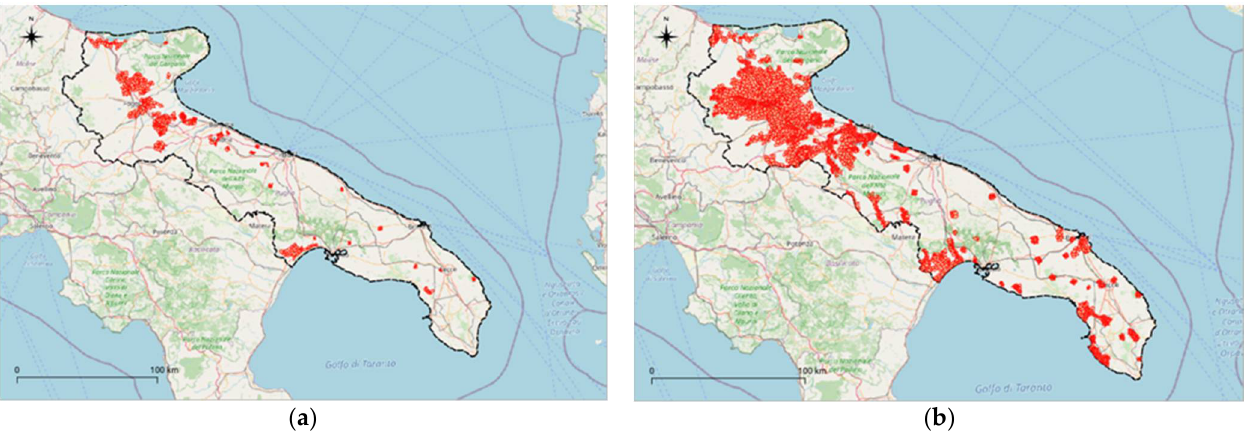
Figure 14. Perimeter of NVZs in Puglia region. ( a ) perimeter of the previous period (2012–2015); ( b ) updated perimeter (27 October 2021). Base map provided by “© OpenStreetMap contributors”.